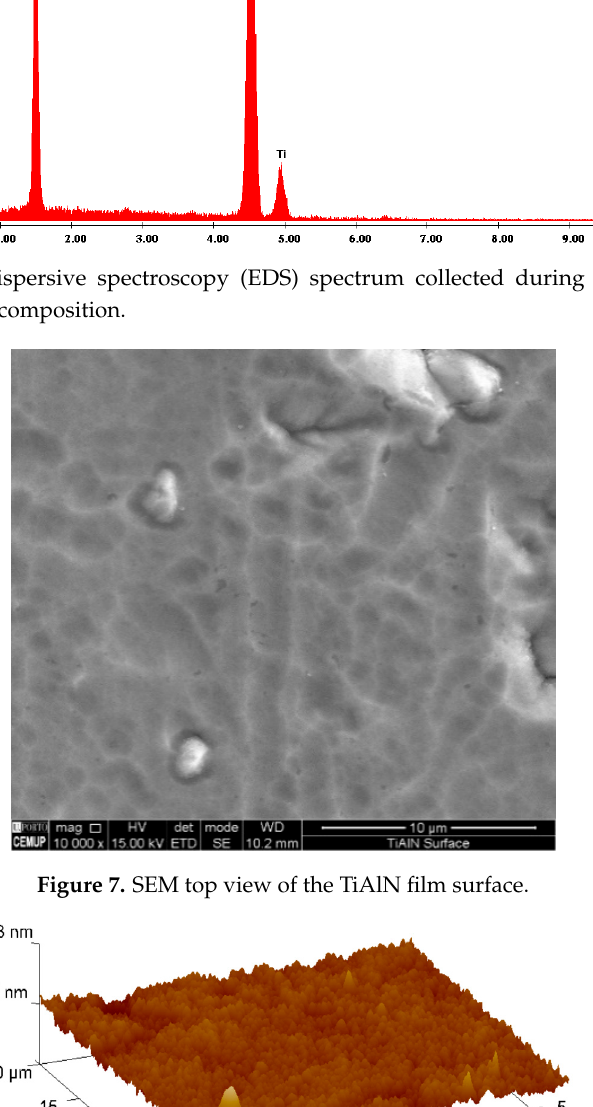
Figure 8. Atomic force microscopy (AFM) 3D analysis of the TiAlN coating morphology.